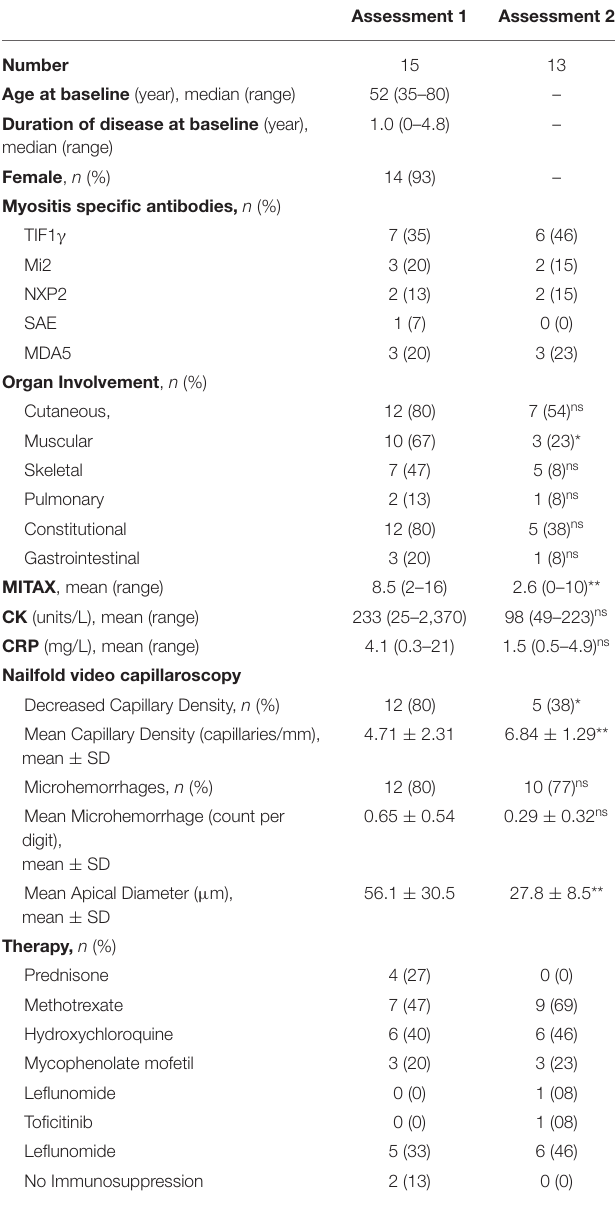
TABLE 1 | Demographic, clinical, and NVC characteristics of patients across two